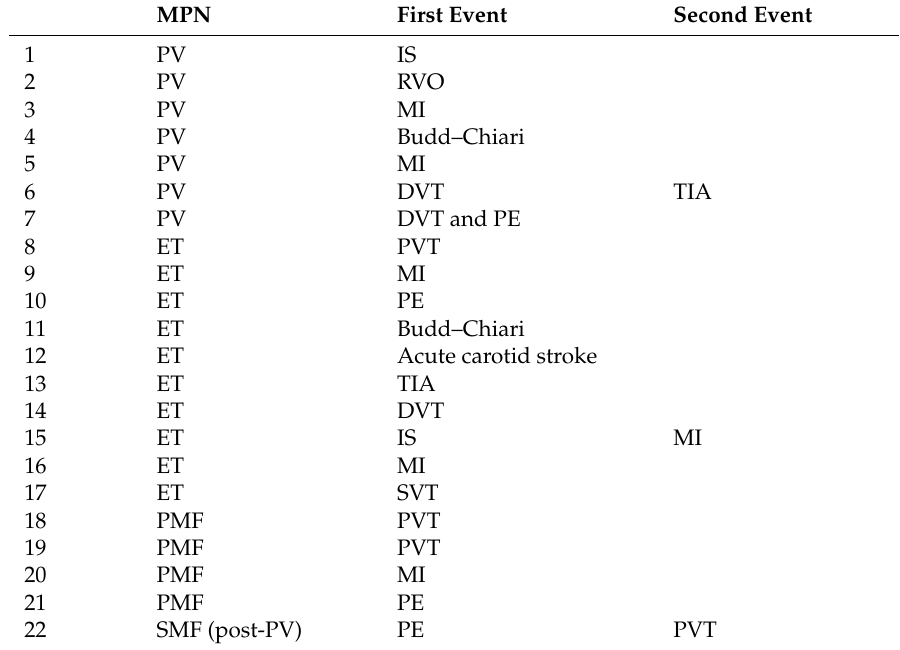
Table 1. Arterial and venous thrombotic events registered in the myeloproliferative neoplasms (MPN) cohort at or after diagnosis. MPN First Event Second Event